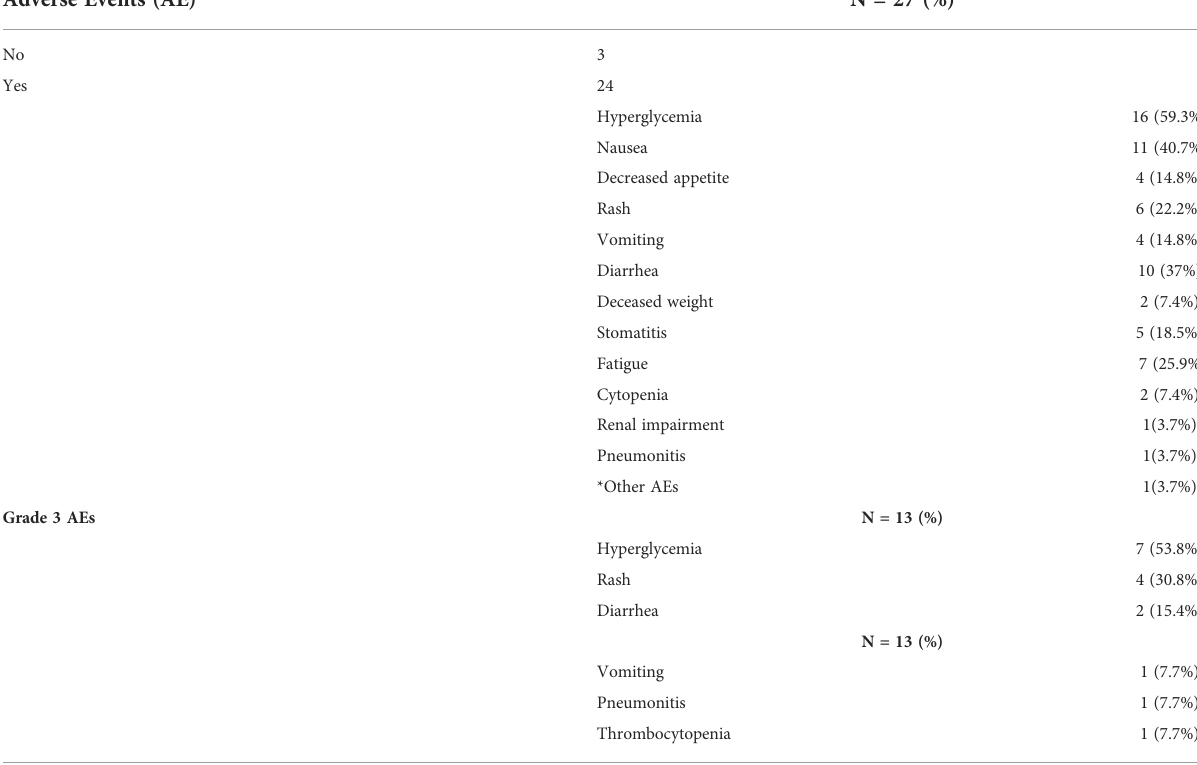
TABLE 3 Adverse events of alpelisib.